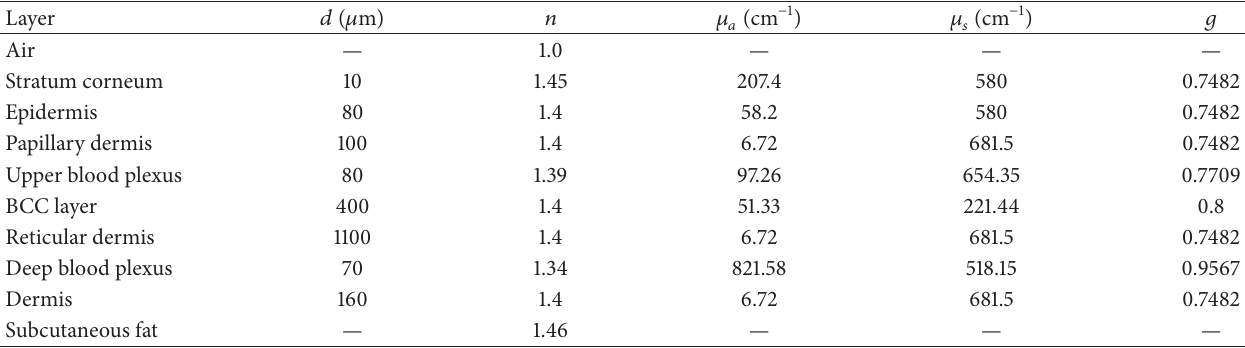
Deep blood plexus Table 4: The optical parameters (𝜇 𝑎 ,𝜇 𝑠 ,𝑔,𝑛) at 442nm of the eight-layer BCC skin optical model. 5% blood factors added to the BCC layer.